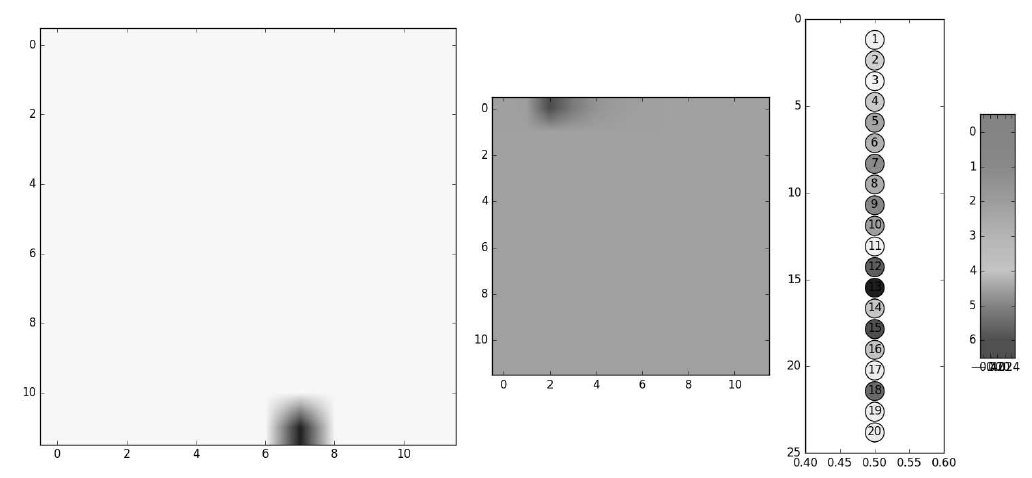
Figure 3. Testing for neurons specialization: response to risk-aversion